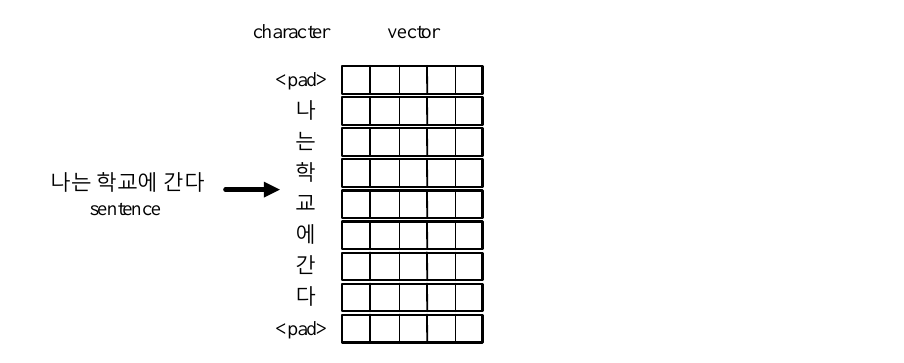
Figure 1. Character-level embedding. (‘ 나는 학교에 간다 ’ in Korean means ‘I go to school’ in Eng-